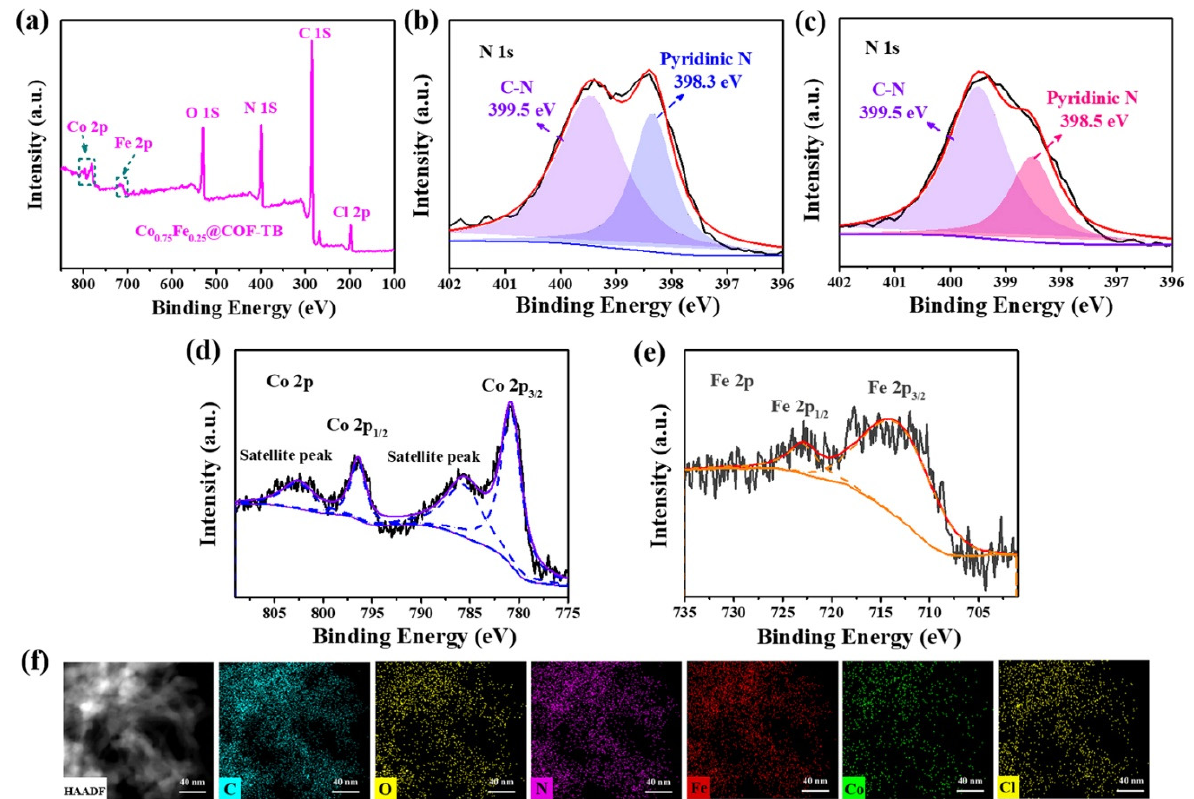
Figure 3. ( a ) XPS spectra of Co 0.75 Fe 0.25 @COF − TB; N 1s spectra of COF − TB ( b ) and Co 0.75 Fe 0.25 @COF − TB ( c ); Co 2p spectra ( d ) and Fe 2p spectra ( e ) of Co 0.75 Fe 0.25 @COF − TB; ( f ) EDS mapping images of Co 0.75 Fe 0.25 @COF − TB.